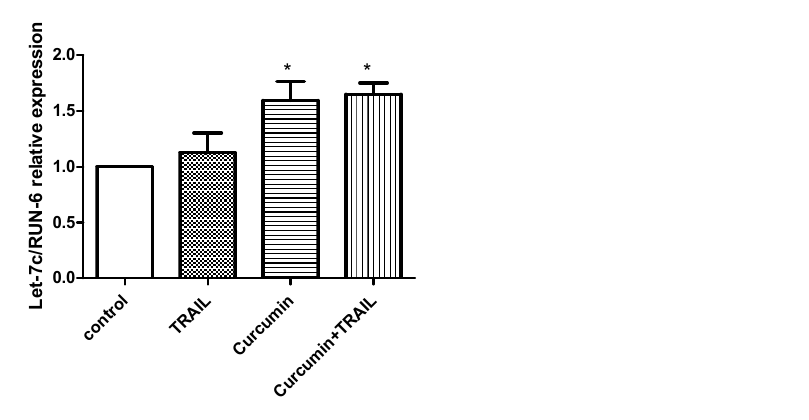
Figure 6. Validation of let-7C upregulation by curcumin or curcumin+ TRAIL combination. Quantita- tive RT-PCR was employed to validate the upregulation of let-7C in cancerous ACHN cells treated with curcumin or curcumin+ TRAIL. Data are expressed as mean ± SEM of three independent experi- ments. * p < 0.05 vs. vehicle treated control. Data were analysed using Paired- t -test and ONE-WAY ANOVA.